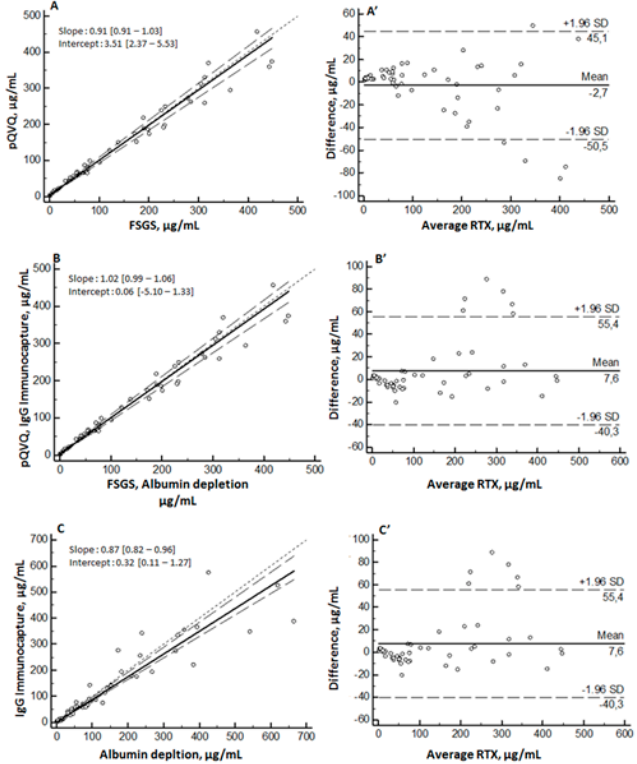
Figure 6. Intra-laboratory comparison of rituximab (RTX) quantification. Passing–Bablok regression (left), with solid line representing regression line and dashed line representing 95% confidence interval for regression line, and Bland–Altman difference-plot (right). Comparison between pQVQ and FSGS by albumin depletion protocol on the same extract sample ( A ), ( A’ ); comparison between FSGS by albumin depletion and pQVQ with IgG-immunocapture ( B ), ( B’ ) with LC-MS/HRMS and comparison between albumin depletion and immunocapture on pQVQ with LC-MS/MS ( C ), ( C’ ). SD: standard deviation.